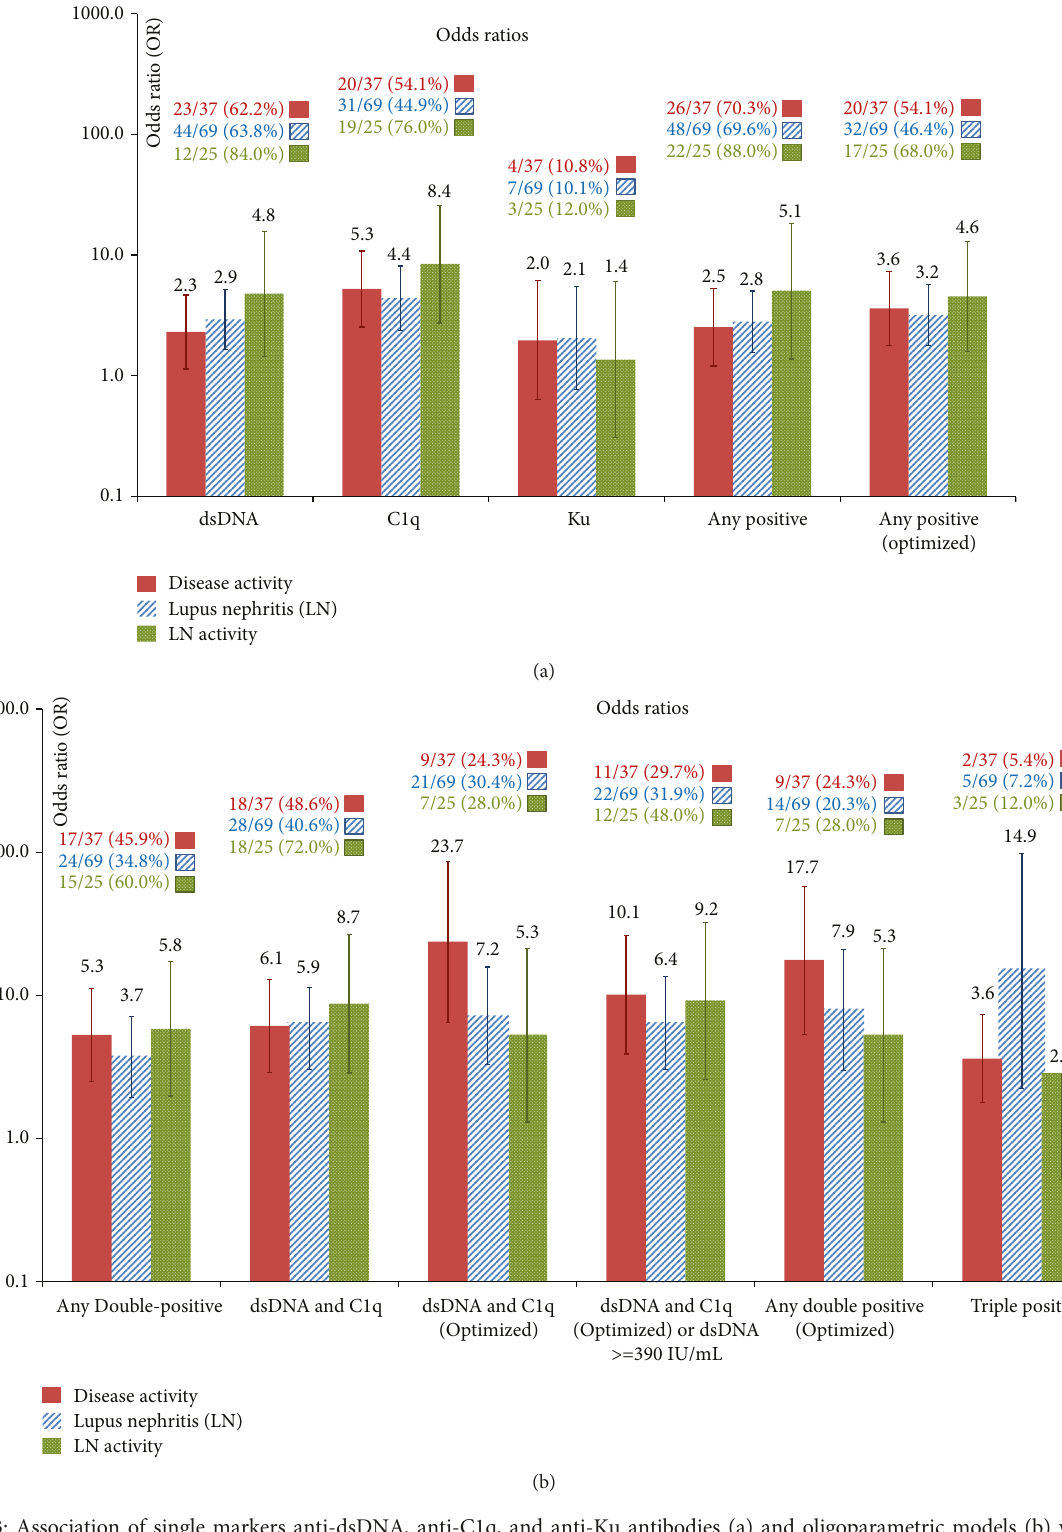
Figure 3: Association of single markers anti-dsDNA, anti-C1q, and anti-Ku antibodies (a) and oligoparametric models (b) with disease activity, lupus nephritis, and lupus nephritis activity. The number of patients and percentage of positive patients are indicated above the graph. The y -axis is shown in logarithmic scale. Error bars indicate the 95% con fi dence intervals. The term optimized pertains to a use of an alternative cut-o ff (other than the manufacturer ’ s cut-o ff ) which gave the best likelihood ratios in Figure